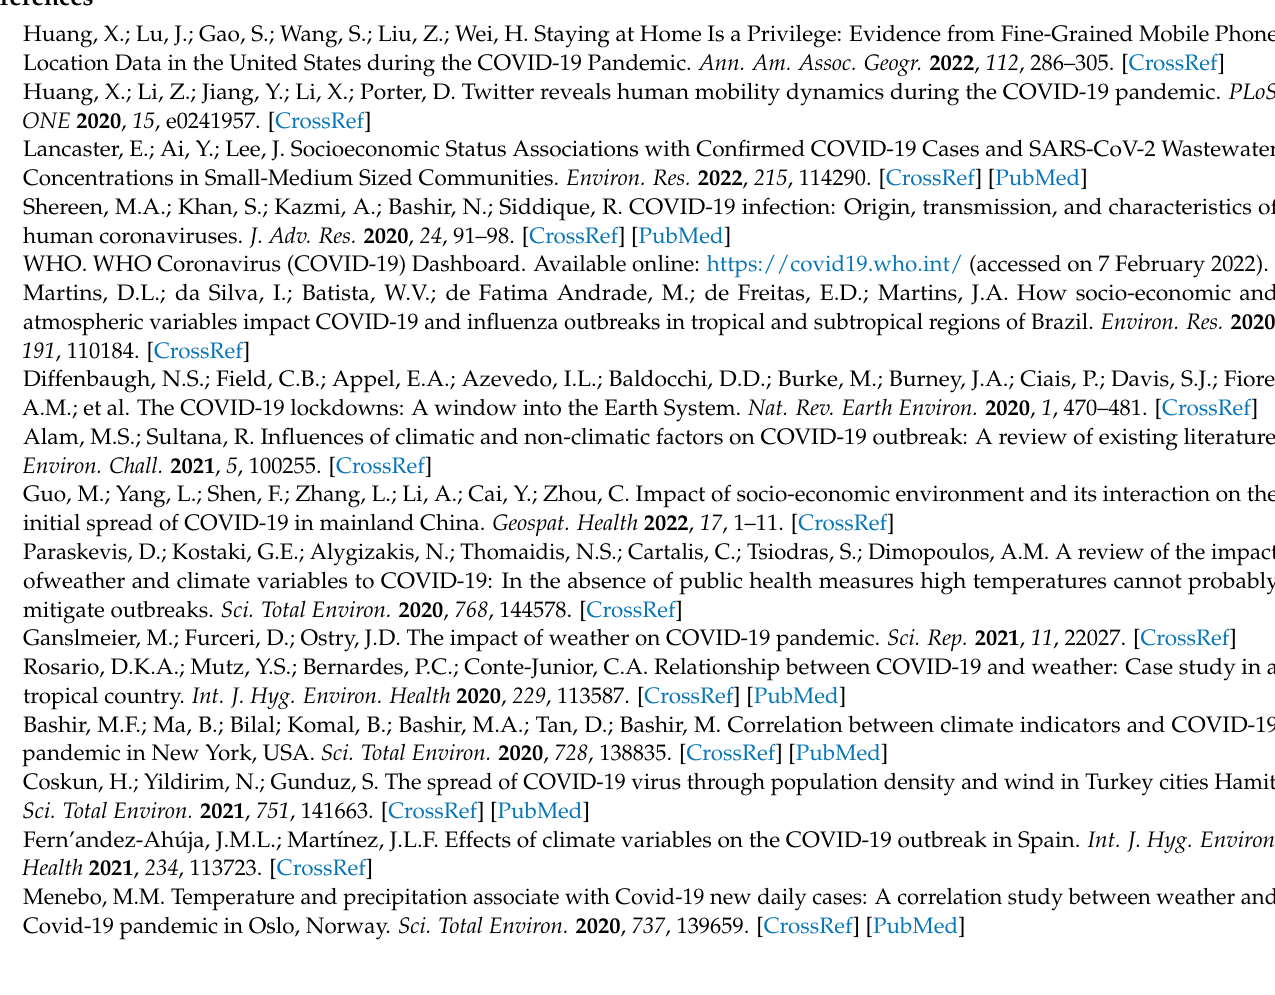
Figure A3. Population in 2020 in Arkansas.